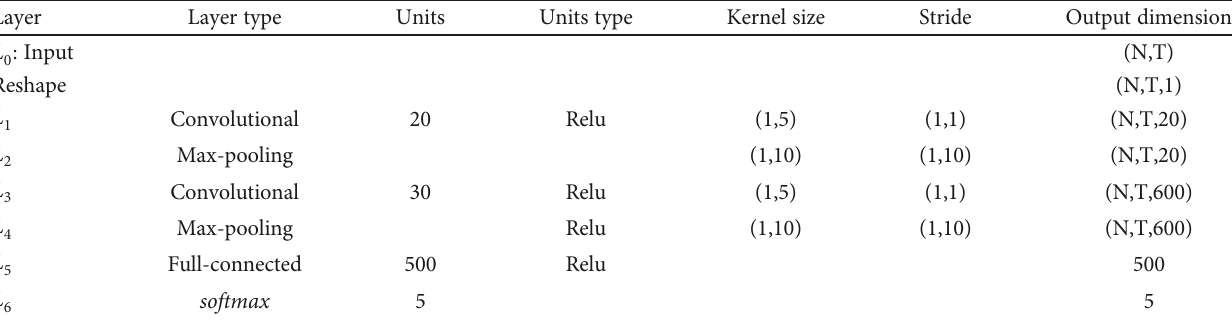
Table 2: Details of CNN architectural